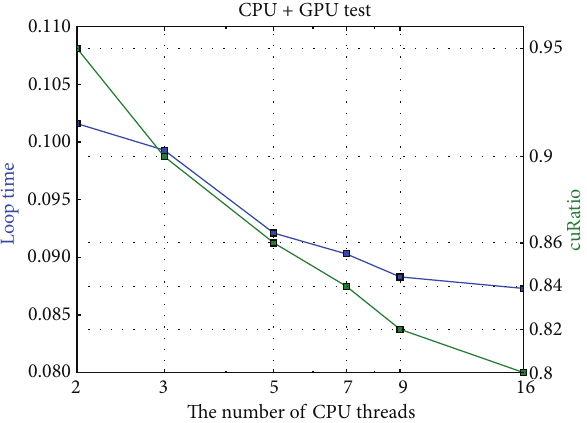
Figure 5: The variation of loop time and cuRatio value over threads number. The problem size is 512 × 256 × 256 . The blue curve means loop time (left 𝑦 axis) and the green curve presents the value of cuRatio (right 𝑦 axis).